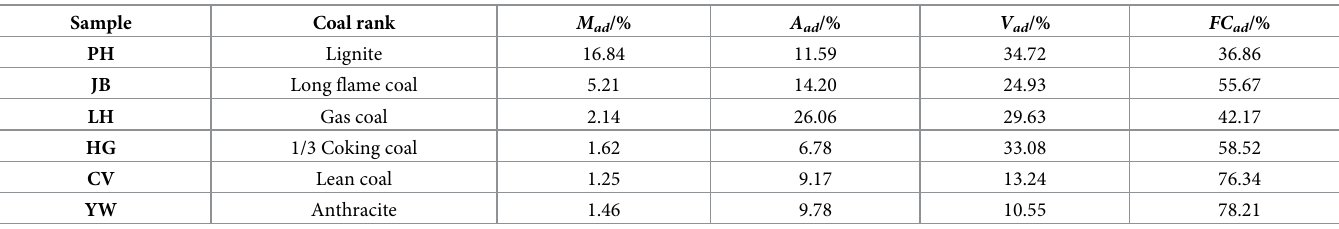
Table 1. Basic parameters of experimental coal